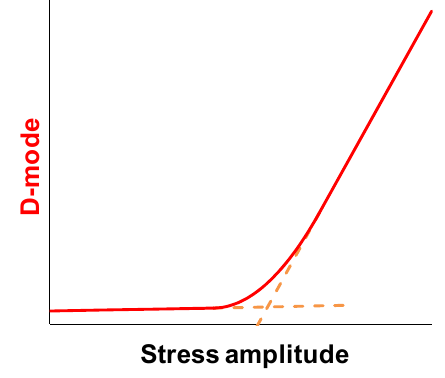
Figure 3: Schematic representation of the typical D-mode trend as a function of the stress